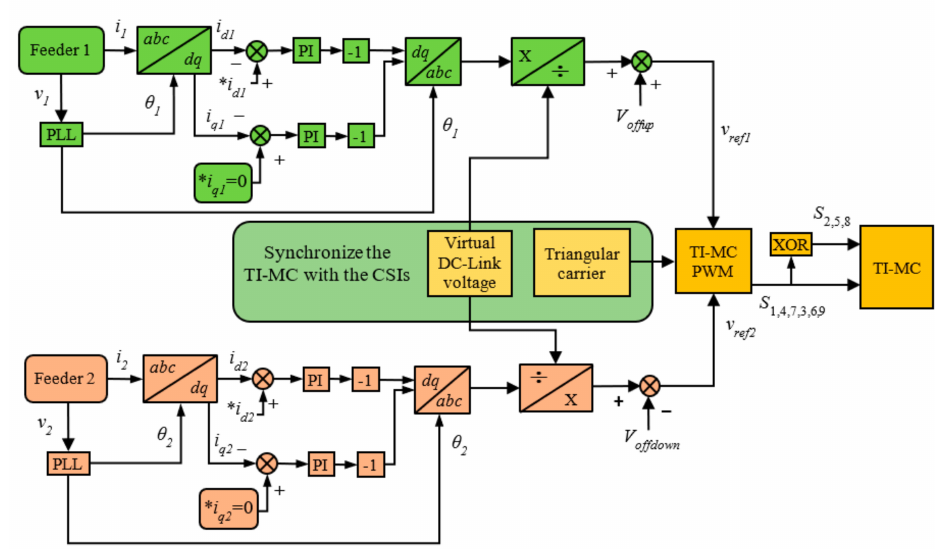
Figure 7. TTI-MC control algorithm and